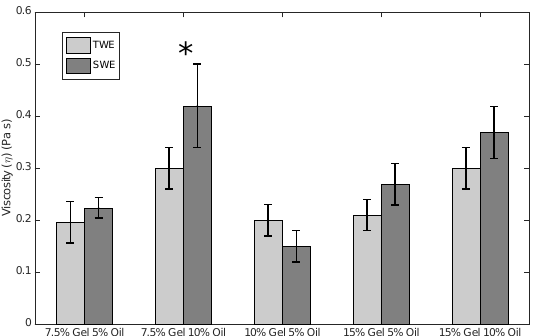
Figure 15. Mean and standard deviations of the shear viscosity for each batch of gelatine. Light gray bars represent TWE measurements whilst those in dark gray are SWE measurements (* p -value <